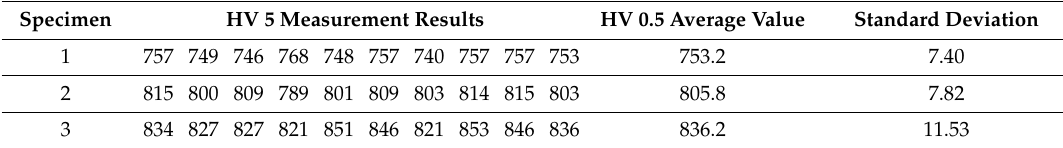
Table 4. HV 0.5 hardness measurement results.